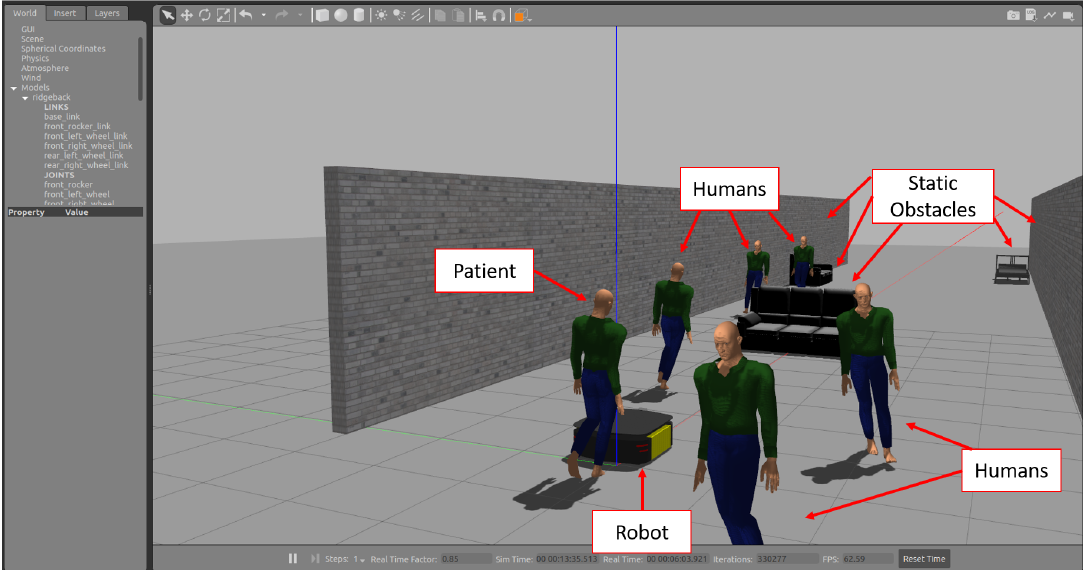
Figure 7. Human–robot co-navigation in